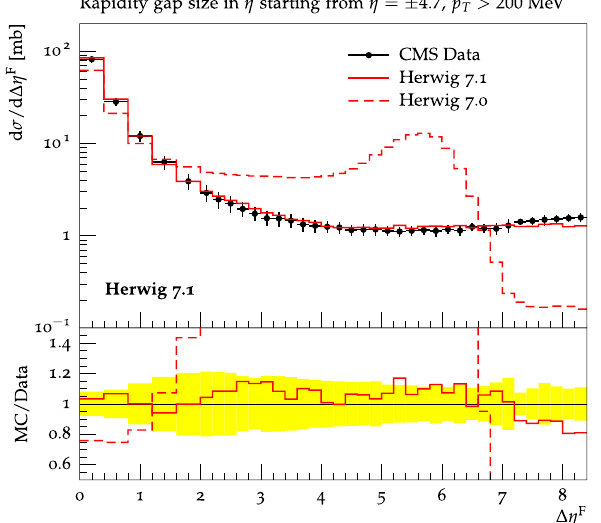
Fig. 7 The distribution of forward rapidity gaps with the new model including a model for diffractive final states (Herwig 7.1), compared to the old model (Herwig 7.0) and CMS data [39]